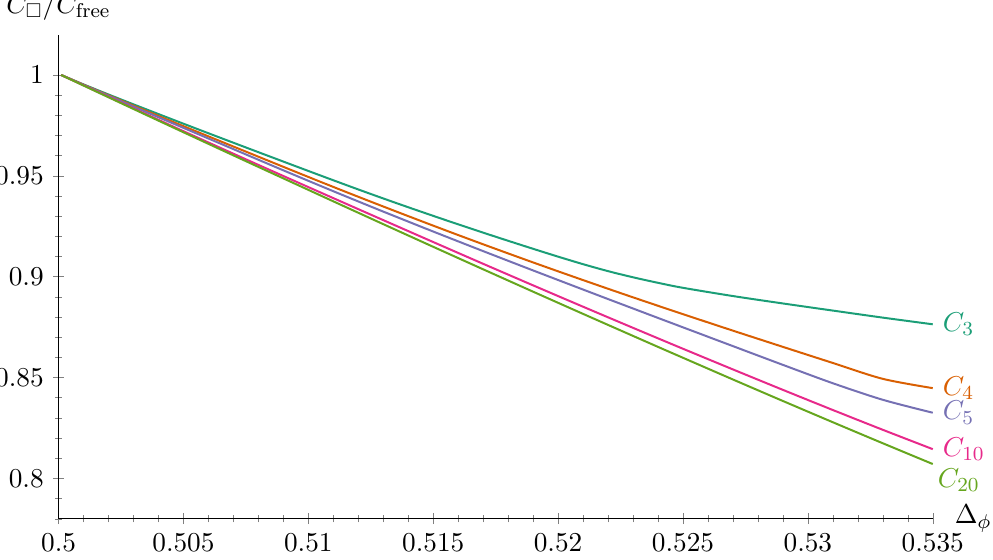
Figure 10 . Lower bound on the central charge as a function of the dimension of (cid:30) . Areas below the curves are excluded in the corresponding